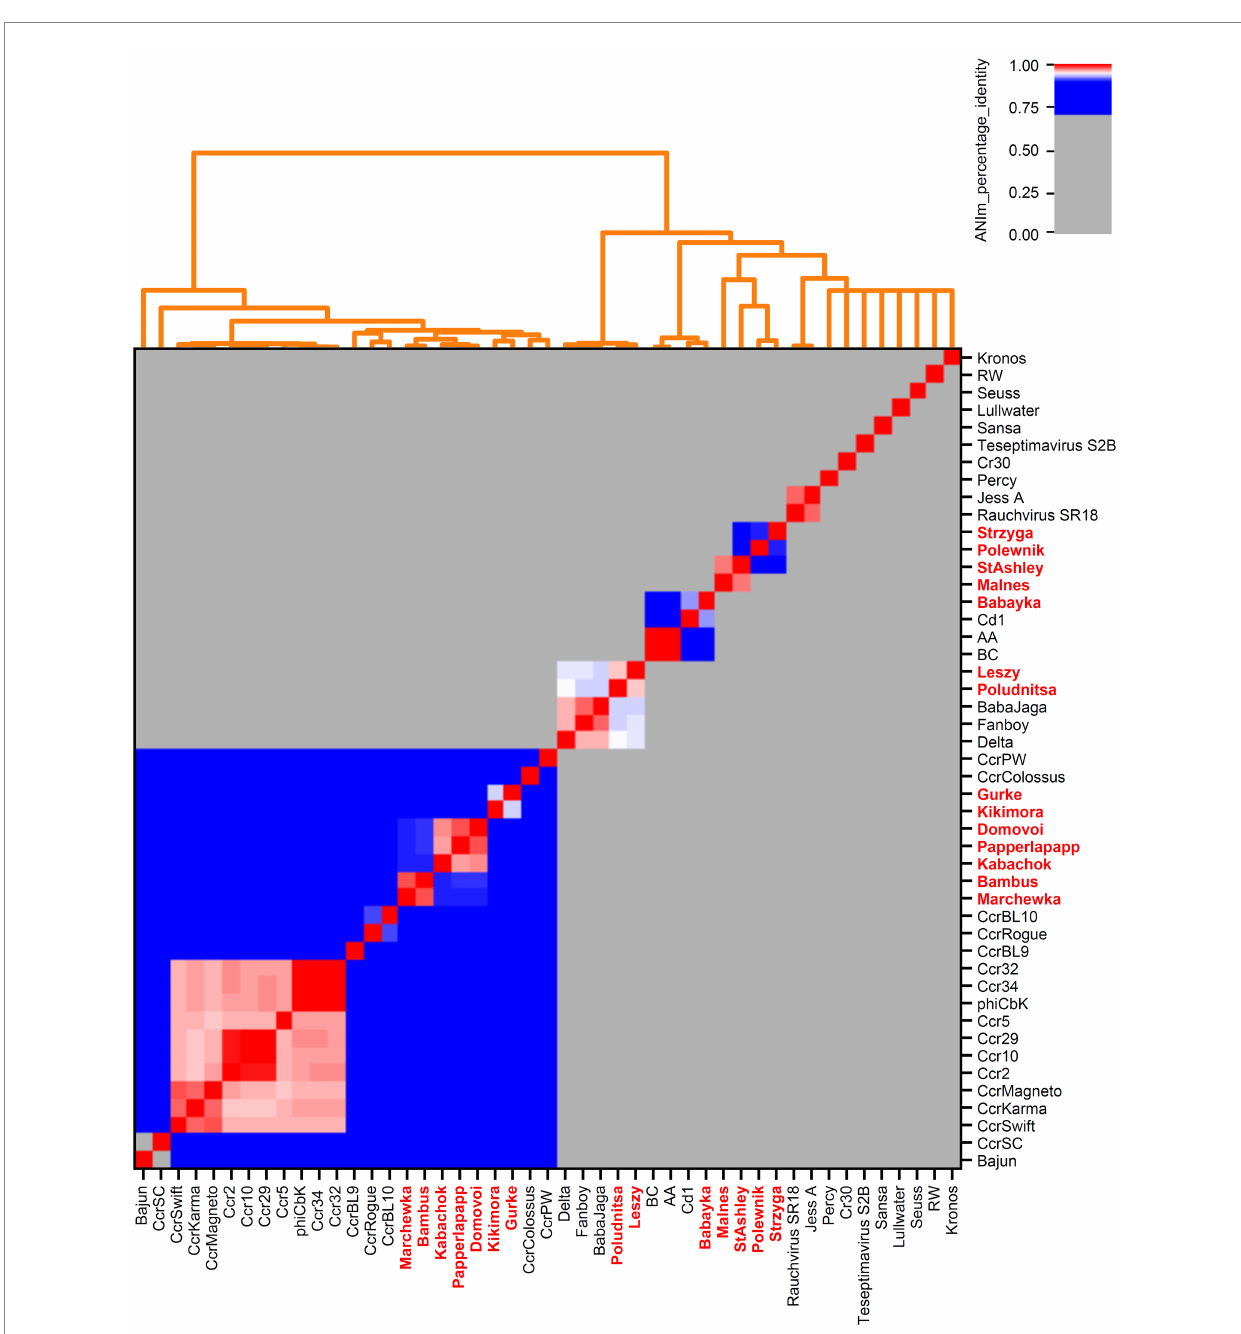
FIGURE 4 Genome-based phylogenetic analysis of Caulobacteraceae -associated bacteriophages. All genomes from NCBI Virus (Brister et al., 2015) and our own isolates (marked in bold red) were examined. Calculations were done with pyani (Pritchard et al., 2016) using ANIm method with default